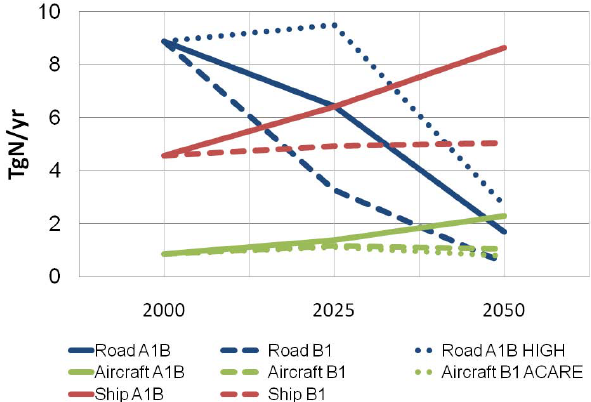
Fig. 1. Time development of NO x emissions from different trans- port sectors in the SRES A1B and B1 scenarios, together with the alternative scenarios B1 ACARE and A1B HIGH (unit: TgNyr − 1